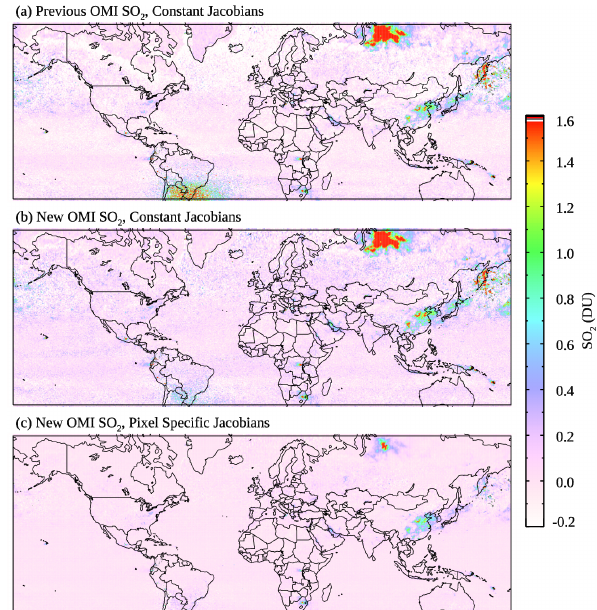
Figure 5. Monthly mean OMI SO 2 VCDs for May 2007 from (a) the previous PBL SO 2 dataset in OMSO2 V1.3 using constant Jacobians, (b) the new OMI anthropogenic SO 2 retrievals using the same Jacobians as in panel (a) , and (c) the new OMI anthro- pogenic SO 2 dataset in OMSO2 V2 using pixel-specific Jacobians as described in Sect. 2.4. Data are gridded to a horizontal resolu- tion of 0.25 ◦ × 0.25 ◦ , and only those pixels near the center of the OMI swath (rows 6–55, 1-based), with SZA < 70 ◦ , and with a small cloud radiance fraction (CRF < 0.3) are